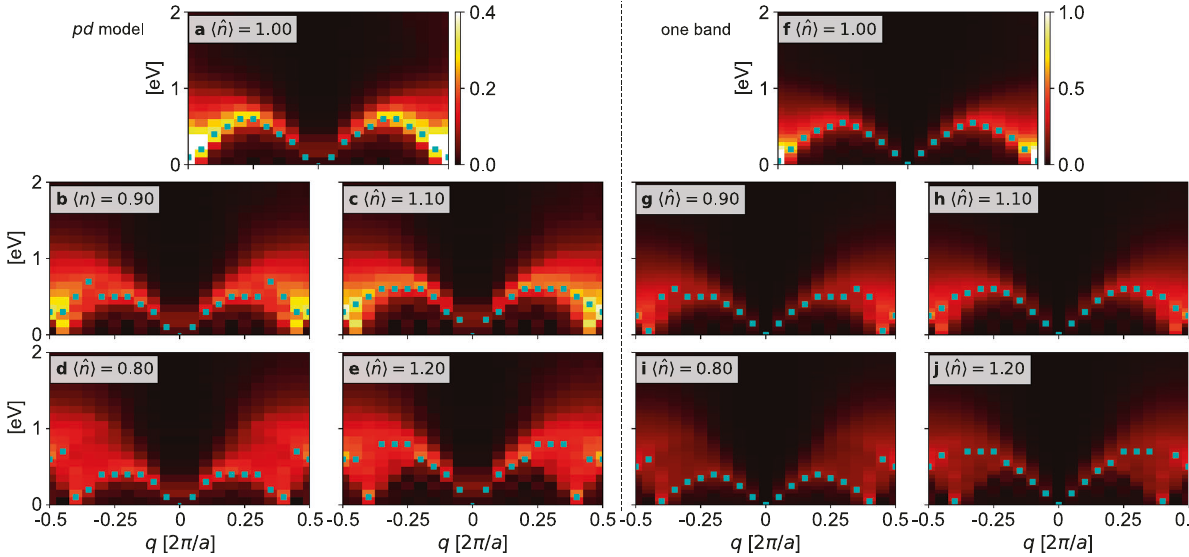
Fig. 5 Zero temperature density matrix renormalization group (DMRG) results for the total dynamical spin structure factor S ( q , ω ) of the multi-orbital pd - and single-band Hubbard models. Panels a − e show the dynamical spin structure S ( q , ω ) as a function of momentum q and energy ω , obtained from DMRG simulations of the multi-orbital model with a Cu − O basis (the pd -model) at various fi llings h ^ n i , as indicated. The parameters for the pd -model include the onsite energies ϵ d = 0, ϵ p , x = 3, and ϵ p , y = 3.5, the hopping integrals ∣ t ( p , x ) d ∣ = 1.5, ∣ t ( p , y ) d ∣ = 1.8, and ∣ t pp ∣ = 0.75, onsite Hubbard interactions U d = 8 and U p = 4, and the interorbital Hubbard interaction U pd = 1, in units of eV. Panels f − j show corresponding results for DMRG simulations of the single-band Hubbard model with nearest-neighbor hopping t = 0.5 eV, next-nearest-neighbor hopping t 0 ¼ 0 : 06 t ¼ 0 : 03 eV, and an onsite Hubbard interaction U = 5.32 t = 2.66 eV. Both sets of results were obtained using chains with N = 20 unit cells and at zero obtained using DMRG. In both Figs. 4 and 5, panels a − e show the cluster sizes and simulation temperatures are the same for the the spectra obtained from the full pd -model while panels f − j two models, and one can directly compare the results shown on show the corresponding results obtained from a single-band both sides of each fi gure. Hubbard model. To compare to the single-band model, we pre- At low-temperature and h ^ n i ¼ 1, the corner-shared cuprates sent the total spin response of the pd -model. We stress that both are charge-transfer insulators with antiferromagnetic correlations.